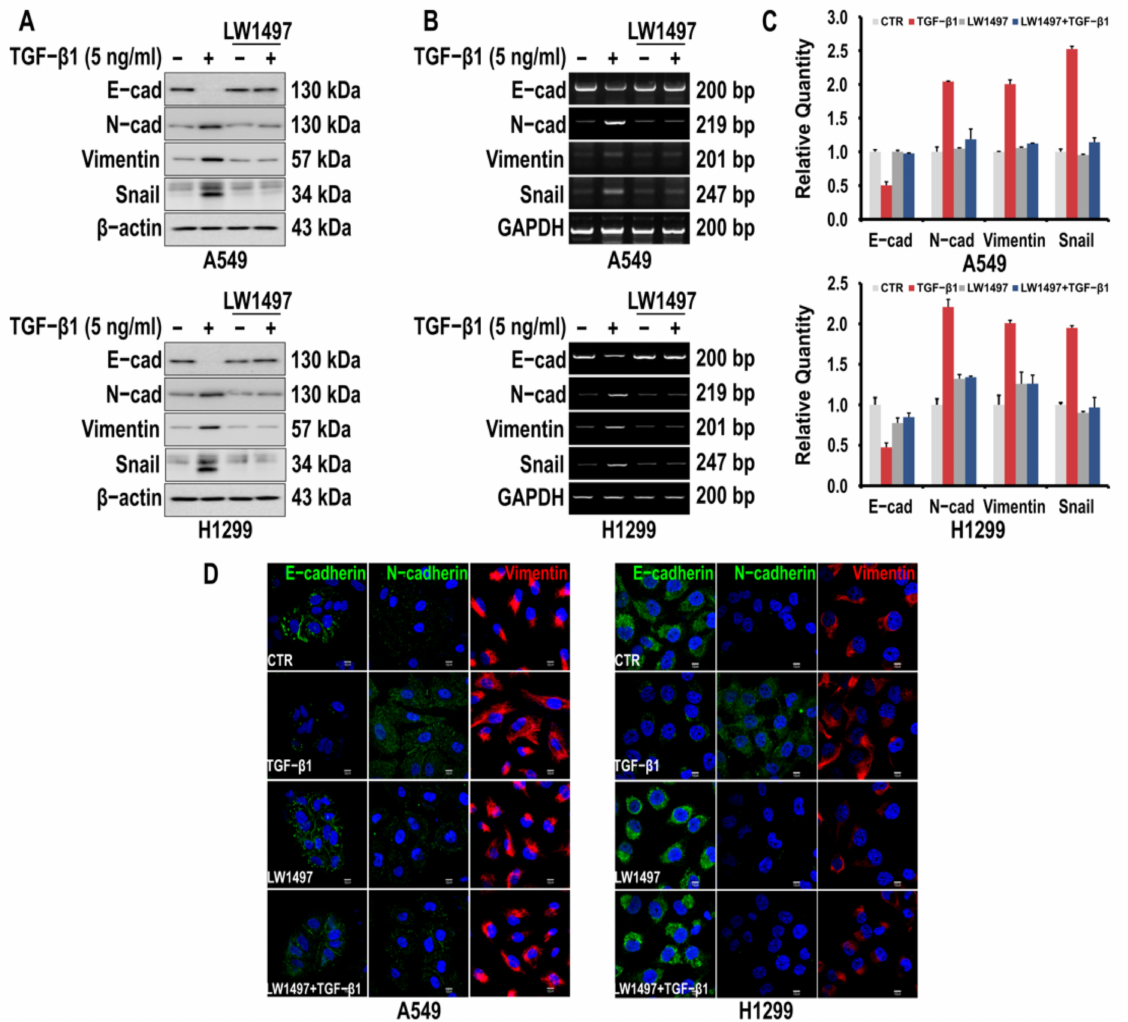
Figure 1. LW1497 inhibits TGF- β 1-induced EMT in lung cancer cells. ( A , B ) A549 and H1299 cells were pretreated with 10 µ M of LW1497 for 2 h and then stimulated with 5 ng/mL of TGF- β 1 for 48 h. The expression levels of E-cadherin, N-cadherin, Vimentin, and Slug were measured by a Western blot ( A ) and RT-PCR ( B ). β -Actin and GAPDH levels were monitored as a loading control for whole-cell extracts. ( C ) qRT-PCR analysis of EMT markers in A549 and H1299 cells. Relative EMT marker’s expression was determined with normalization against GAPDH. To compare the ratio between the control and the experimental groups, the fold change was calculated based on the control. ( D ) Confocal microscopic analysis of EMT markers in A549 and H1299 cells. DAPI staining was used to identify the nucleus. Bar, 10 µ